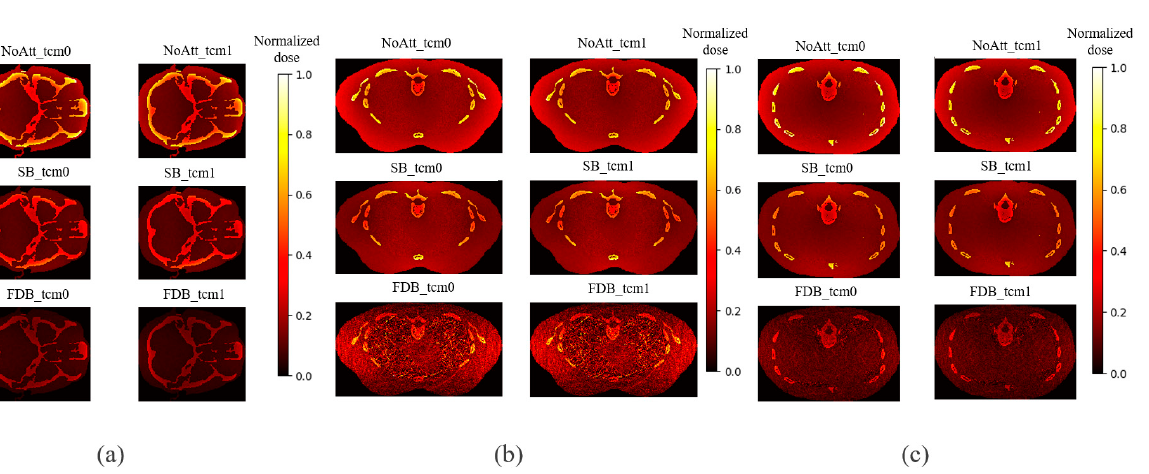
Figure 6. Dose map for adult ( a ) head, ( b ) thorax and ( c ) abdomen scans using different scanning protocols.